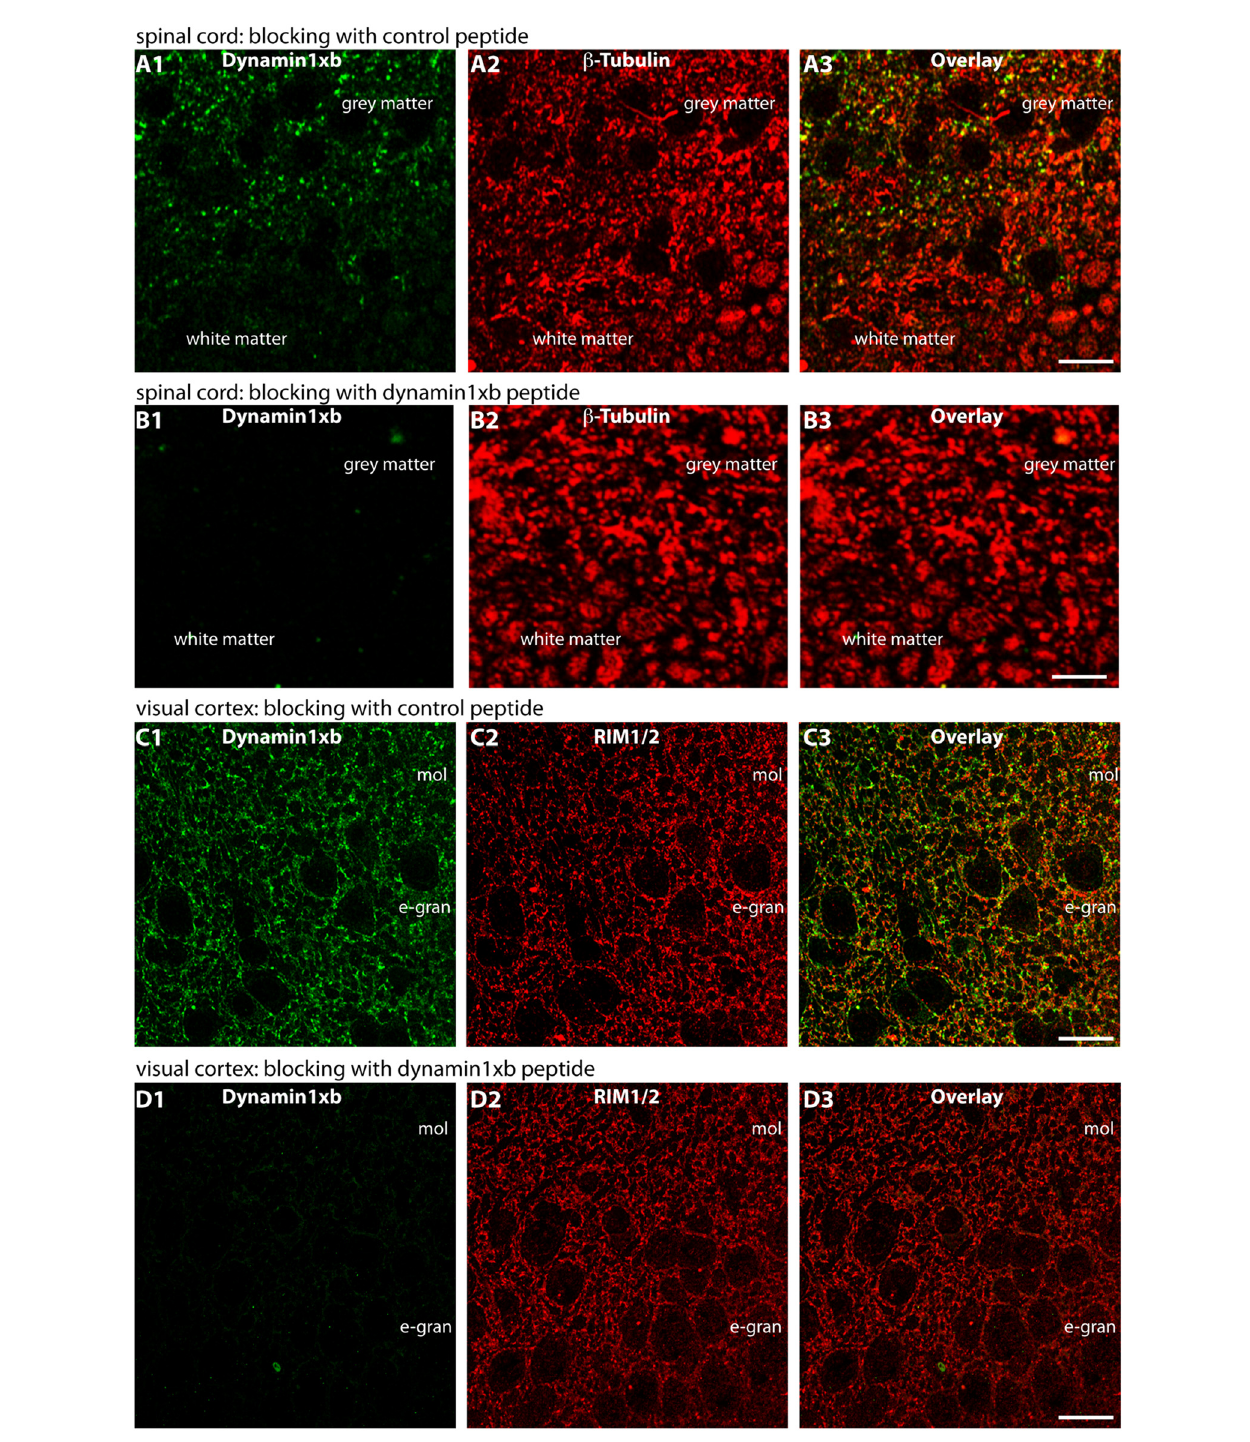
FIGURE 8 | Semi-thin (0.5 µ m-thin) sections of the mouse spinal cord (A,B) or mouse visual cortex (C,D) immunolabeled with the monoclonal antibody against dynamin1xb that was pre-absorbed either with a control peptide (A,C) or with the dynamin1xb peptide “PP12” against which the monoclonal antibody was raised (B,D) . The strong dynamin1xb imunosignal in the synaptic layers of the spinal cord and the visual cortex was completely abolished if the antibody against dynamin1xb was pre-absorbed with the “PP12” peptide (B,D) whereas the synaptic immunolabel of dynamin1xb was completely unaffected if a control peptide was used (A,C). Anti- β -tubulin immunolabeling in (A,B) and anti-RIM immunolabeling in (C,D) was completely unaffected by both of these treatments. Figure 8 was obtained by confocal microscopy. Abbreviations: mol, molecular layer; e-gran, external granule cell layer. Scale bars: 10 µ m.